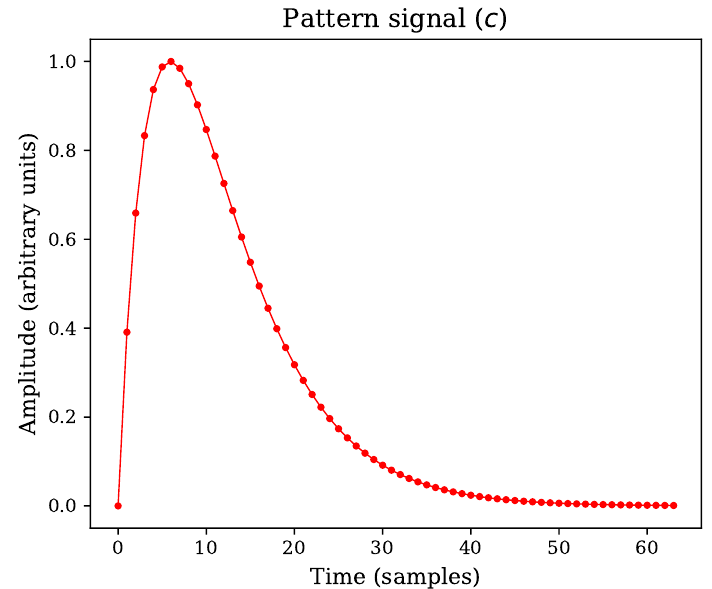
Figure 8. Pattern signal with parameters N = 64, τ = N /5, and p = 45/100, as it was used in the simulation